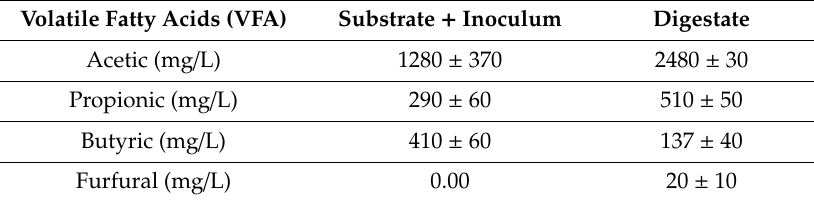
Table 7. Characterisation of volatile fatty acids in the substrate and